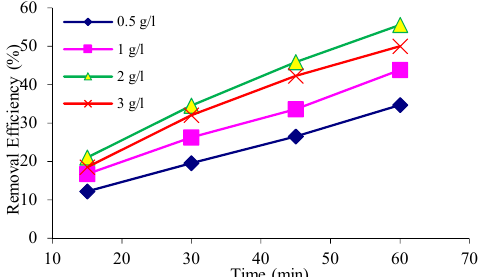
Fig. 6. Effect of nanoparticle concentration on COD removal